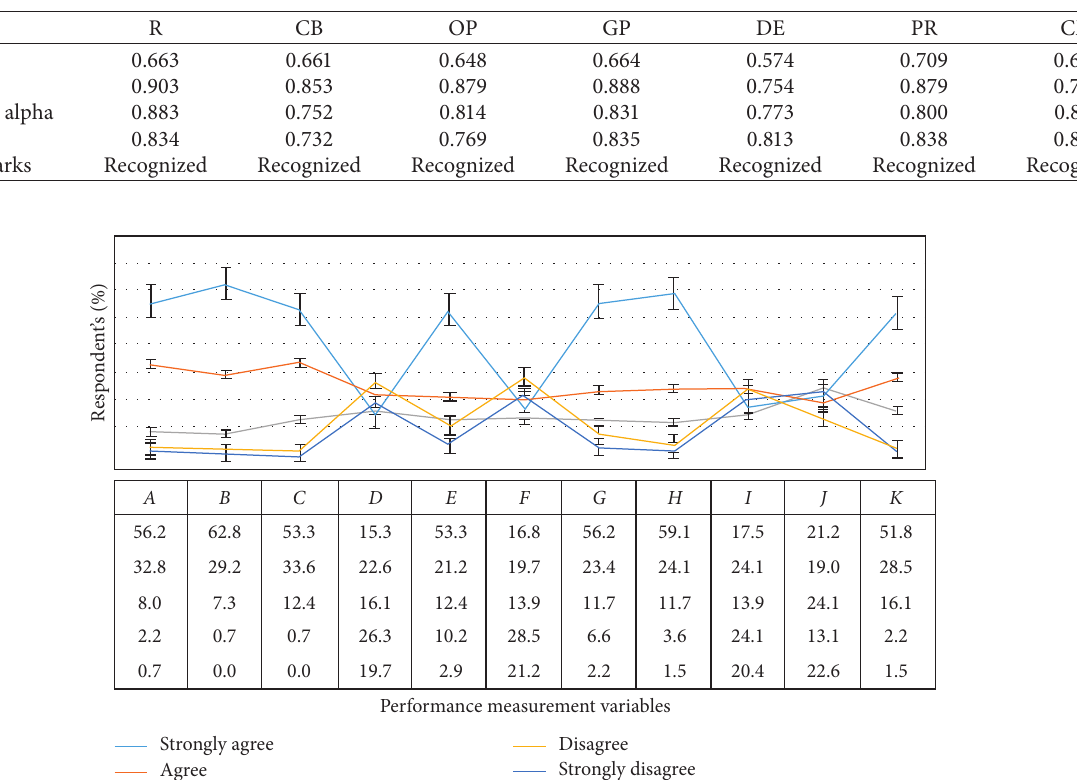
Table 6: Convergent validity test